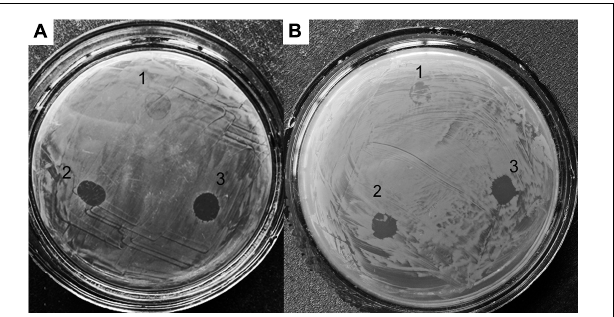
FIGURE 4 | Lytic activities of Lysobacter sp. XL1 (cid:49) alpB :: tet (1) , Lysobacter sp. XL1 (cid:49) alpB::alpB (2) , and wild-type Lysobacter sp. XL1 (3) vesicle preparations with respect to live test cultures. (A) S. aureus 209P. (B) M. luteus